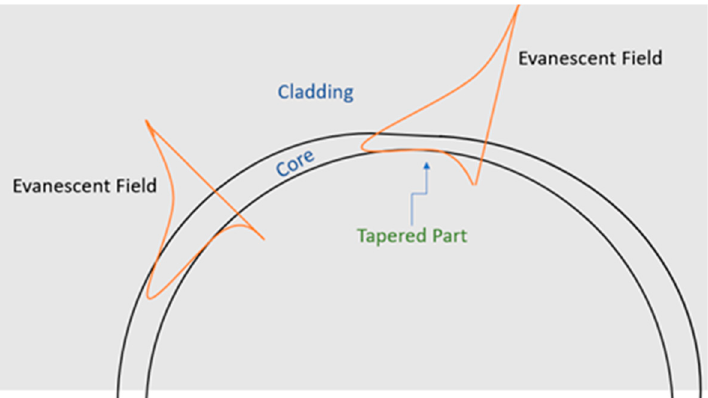
Figure 2. Illustration of evanescent field propagation in the tapered part compared to the strip part.